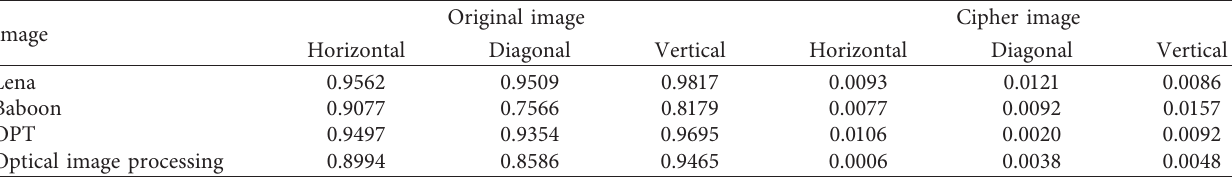
Table 1: Calculation of CC value along horizontal, diagonal, and vertical of original and cipher images.